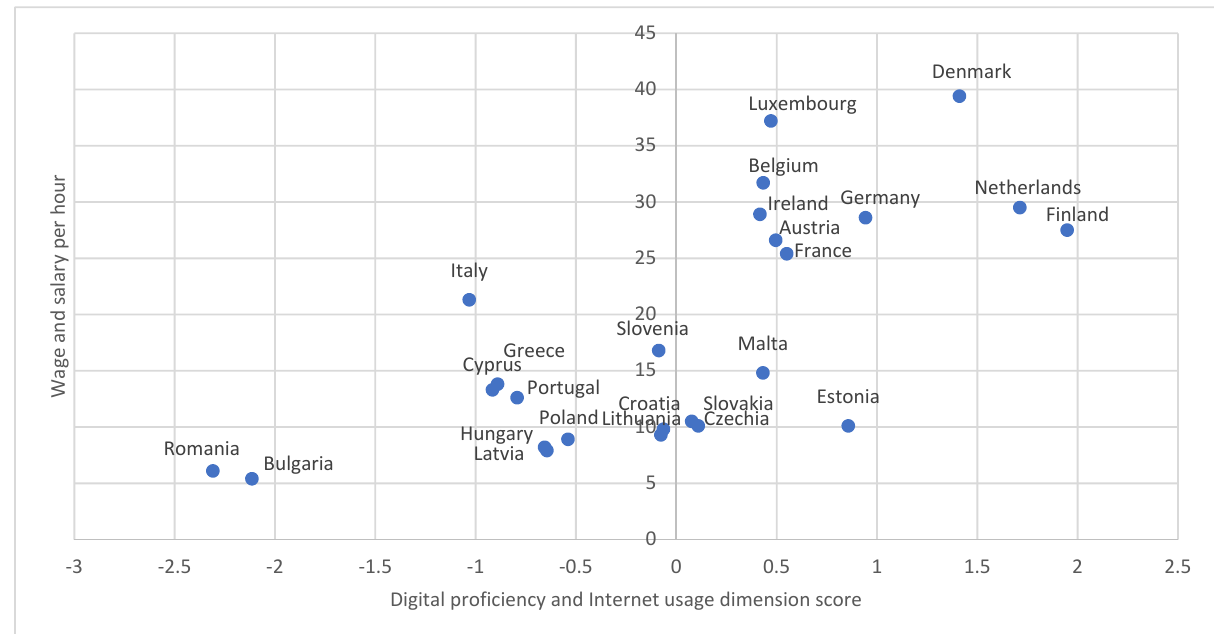
Figure 1. Digital proficiency and Internet usage component and wages. Source: authors’ own calculations.